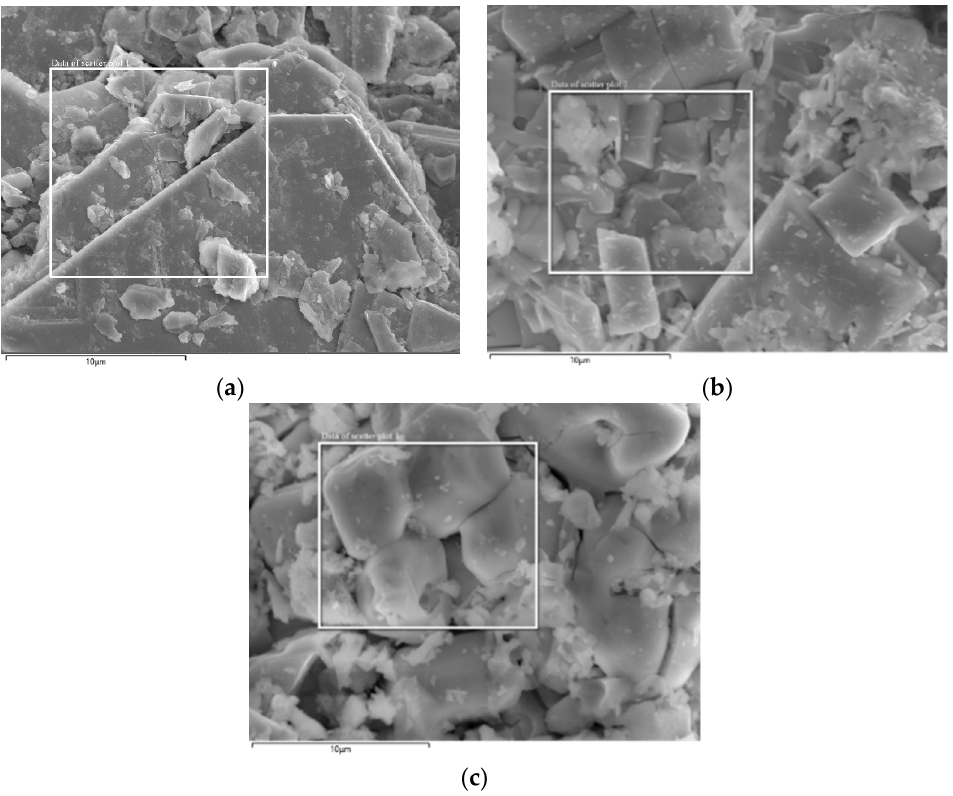
Figure 4. SEM images of different samples. ( a ) Molybdenum concentrate; ( b ) Molybdenum calcine; ( c ) Ammonia leaching residue.